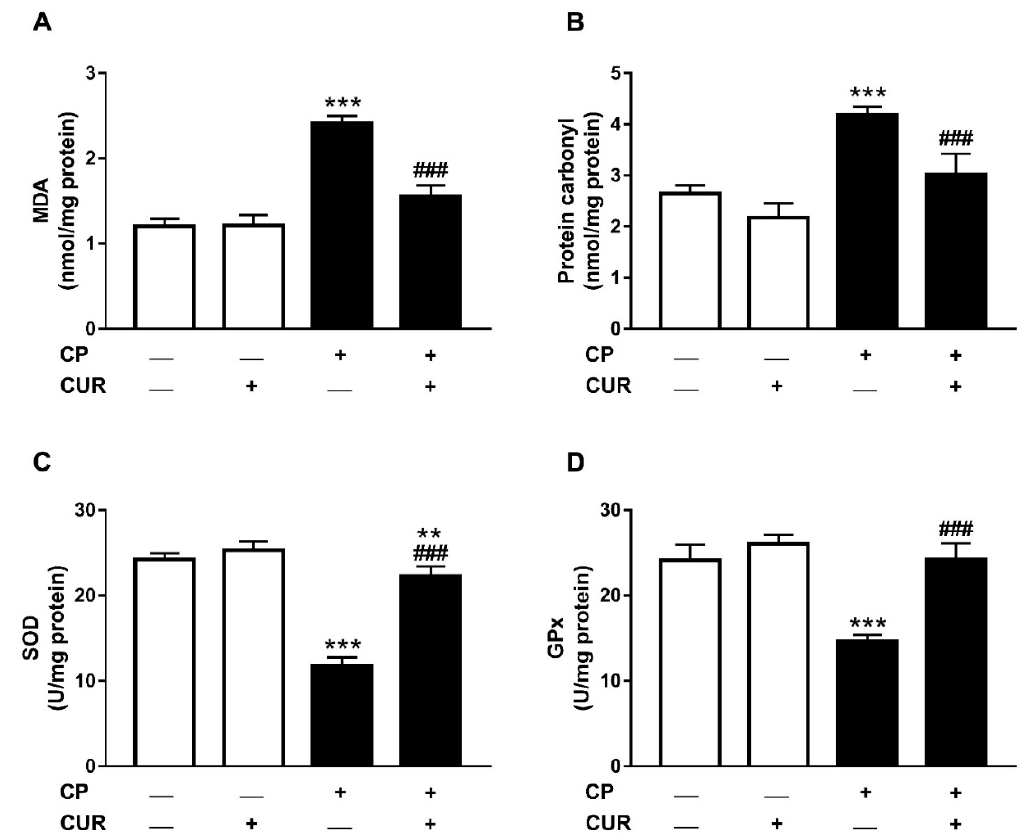
Figure 5. Antioxidant effect of CUR in lung of CP-induced rats. CUR decreased MDA ( A ) and PCO ( B ), and increased SOD ( C ) and GPx ( D ) in lung of CP-induced rats. Values are expressed as mean ± SEM, n = 8, ** p < 0.01 and *** p < 0.001 versus control and ### p < 0.001 versus CP.